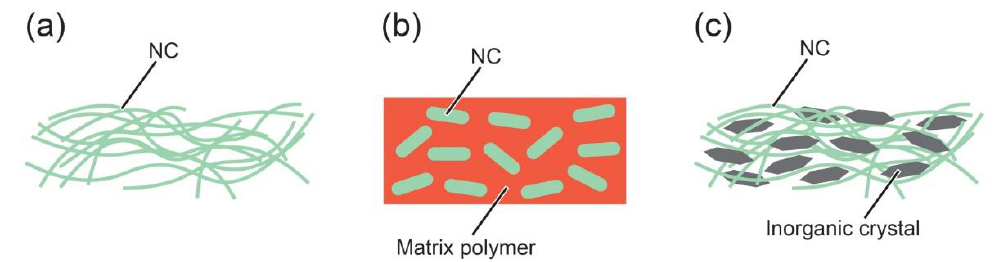
dissipation materials; ( b ) NCs as thermally conductive fillers; ( c ) NCs as scaffolds to maintain composite